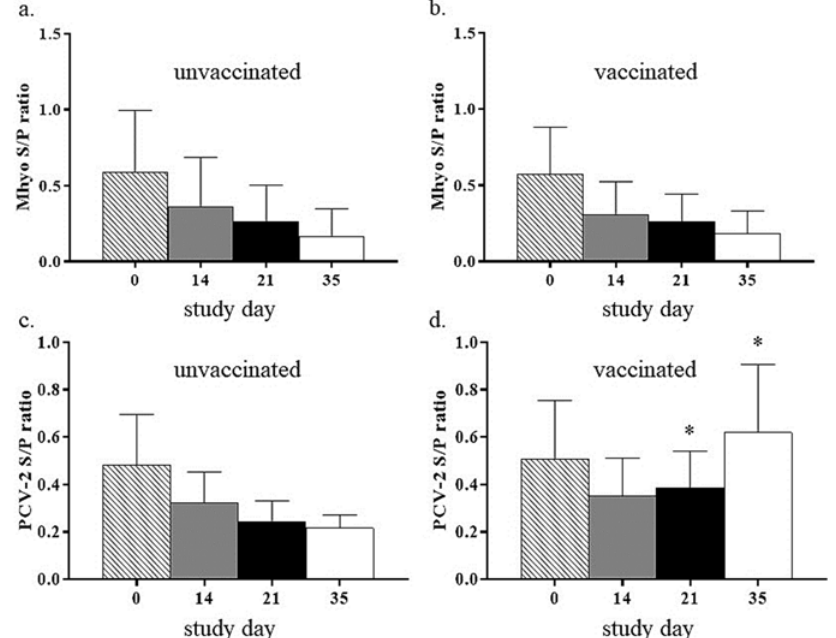
Figure 1. Sample to positive (S / P) ratios to Mycoplasma hyopneumoniae (Mhyo) and porcine circovirus type 2 (PCV-2). Pigs were either unvaccinated (n = 31) or vaccinated with a Mhyo / PCV-2 vaccine (n = 32) prior to weaning. ( a , b ). For both unvaccinated and vaccinated groups, the Mhyo S / P ratios declined over time. ( c ). For the PCV-2 unvaccinated groups, the PCV-2 S / P ratio declined over time. ( d ). For the PCV-2 vaccinated groups, the PCV-2 S / P ratio declined and then rebounded over time. ( c , d ). For days 21 and 35 the PCV-2 S / P ratio was higher when compared to unvaccinated controls ( p < .05, asterisks).